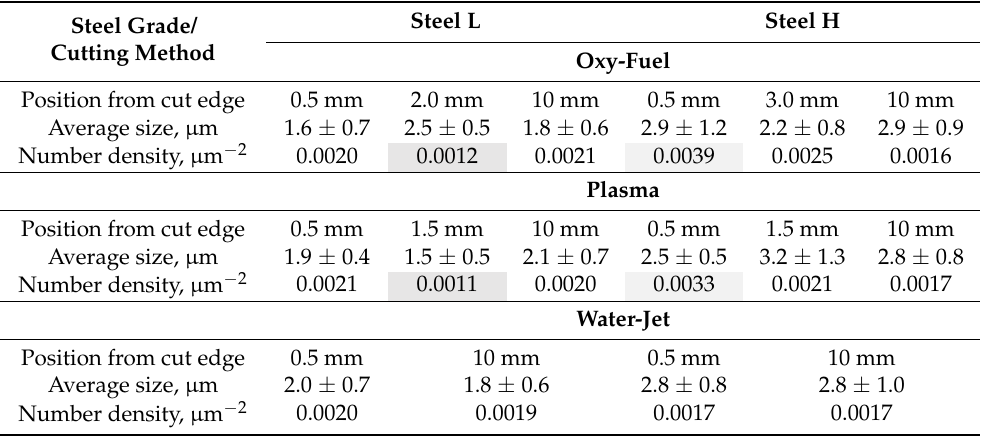
Table 3. Average parameters of coarse (TiMoV)(CN) particles studied with optical microscopy (at 10 mm away from the cut edge no heat effect was observed, therefore the microstructure at this position was considered as the